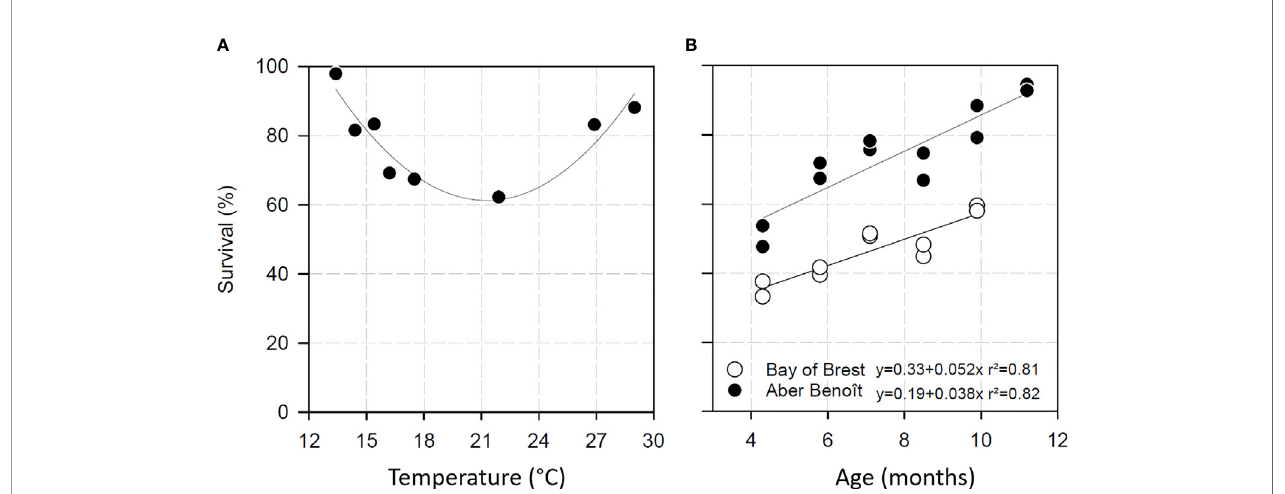
FIGURE 2 | Survival of Paci fi c oysters exposed to POMS according to temperature (A) and age (B) . (A) C. gigas survival after exposition to POMS in mesocosm. Oyster mortalities after 16 days of exposition were maximal at temperatures ranging from 16.2 and 21.9°C. Lower and upper temperatures diminished POMS permissiveness. Data were extracted from (17). (B) Survival of Paci fi c oysters exposed to POMS according to their age in two Atlantic coast locations (Aber Beno ı ̂ t and Bay of Brest). The data are modi fi ed from